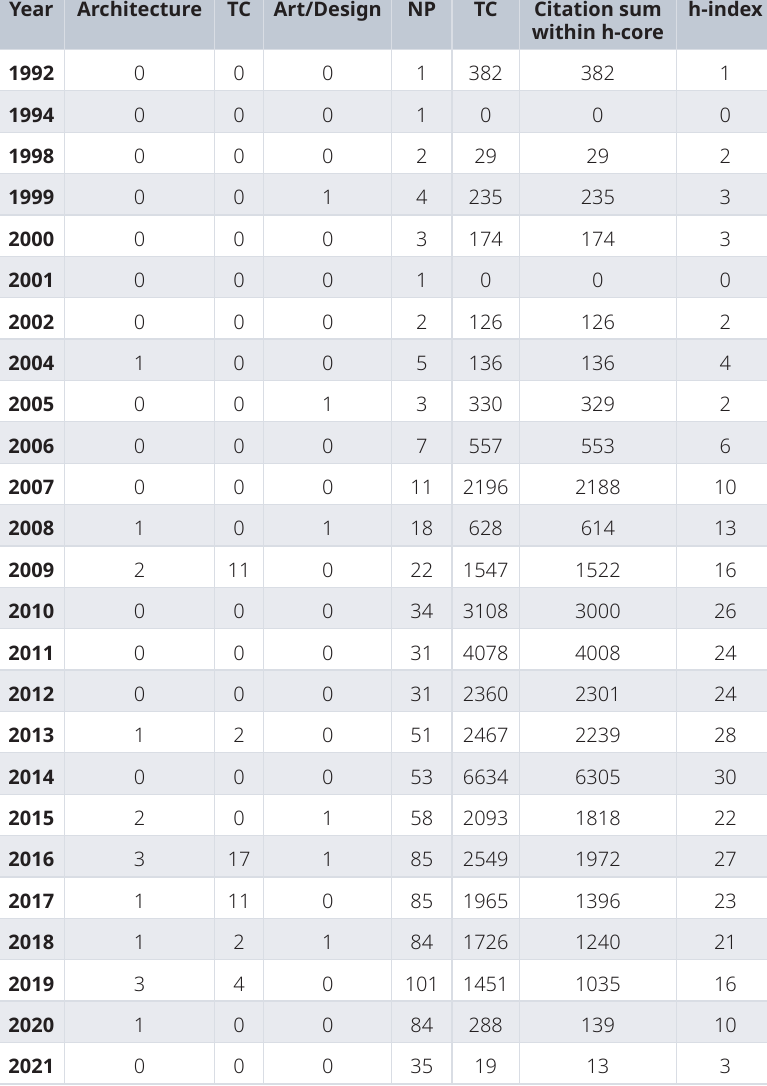
Table 1. Annual research growth and citation’s